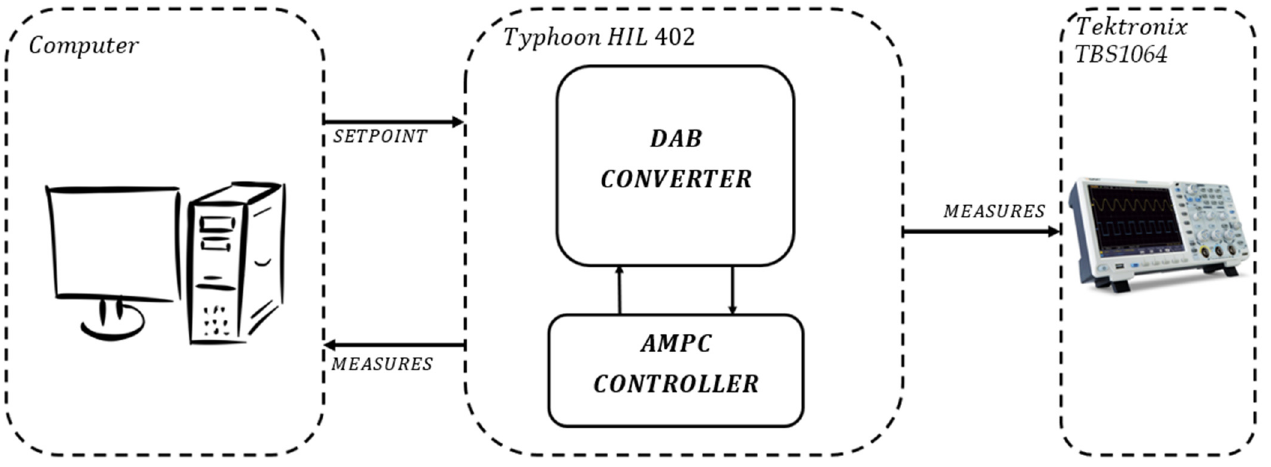
Figure 12. Hardware-in-the-loop experimental setup.